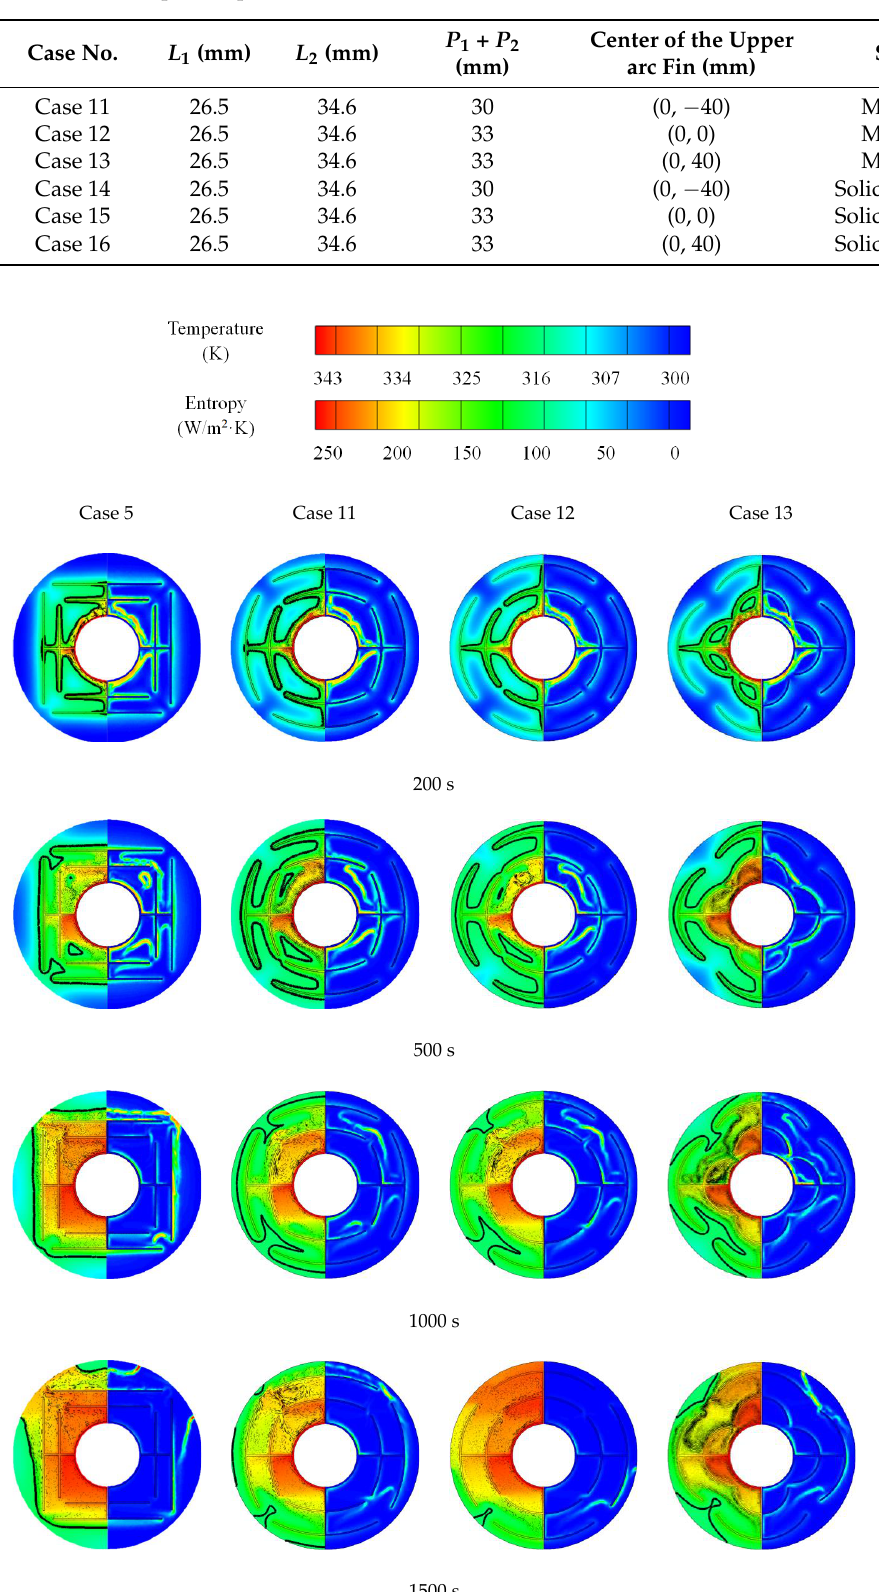
Figure 18. Melting process for Cases 5, 11 – 13.